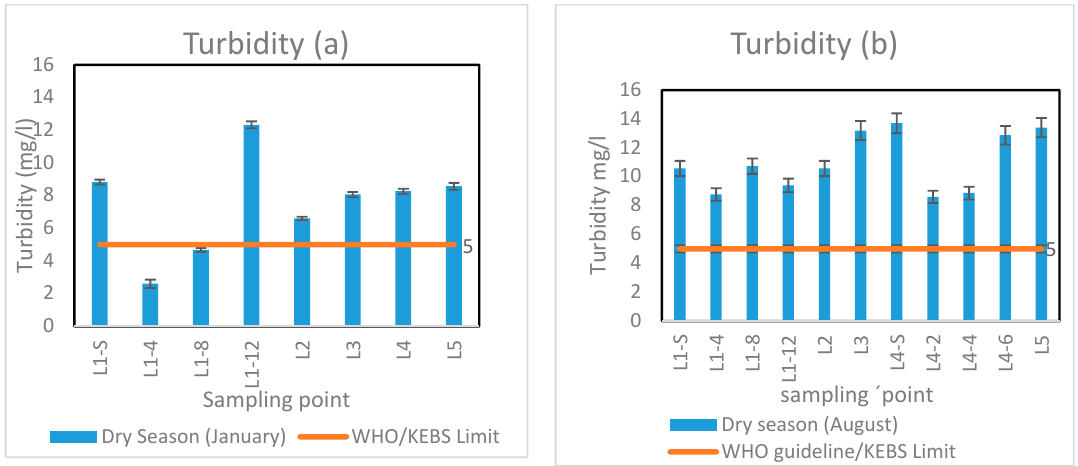
Figure 8. Turbidity concentration at various sampling points: ( a ) January 2019 and ( b ) August 2019. The calcium, magnesium, sodium, potassium, total alkalinity, and total hardness concentrations in Rungiri quarry reservoir in January and August 2019 are presented in Tables 6 and 7. Table 6. Concentration of chemical parameters in Rungiri quarry reservoir in January 2019.